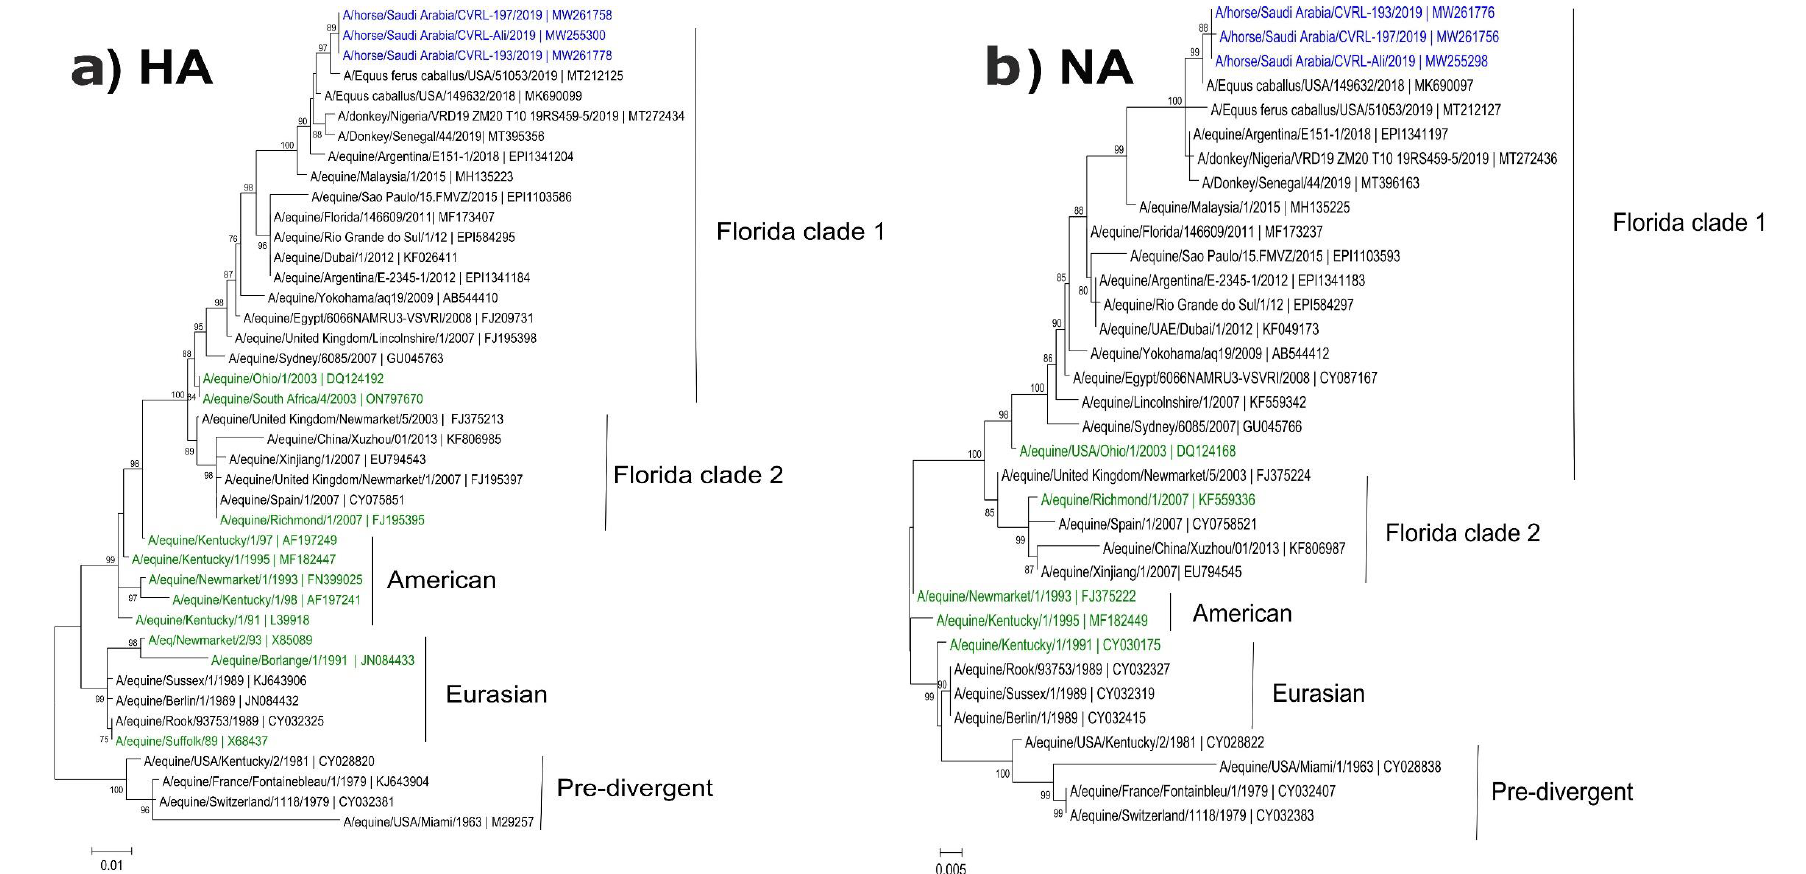
Figure 1. Phylogenetic analysis of haemagglutinin and neuraminidase genes of Saudi EIV subtype H3N8 strains in comparison to representative published sequence. ( a ) Phylogeny of the hemagglutinin (HA) gene. ( b ) Phylogeny of the neuraminidase (NA). Phylogenetic trees were created using the maximum likelihood method with 1000 bootstraps. Saudi strains are presented in blue. Virus strains used for vaccine production are presented in green.